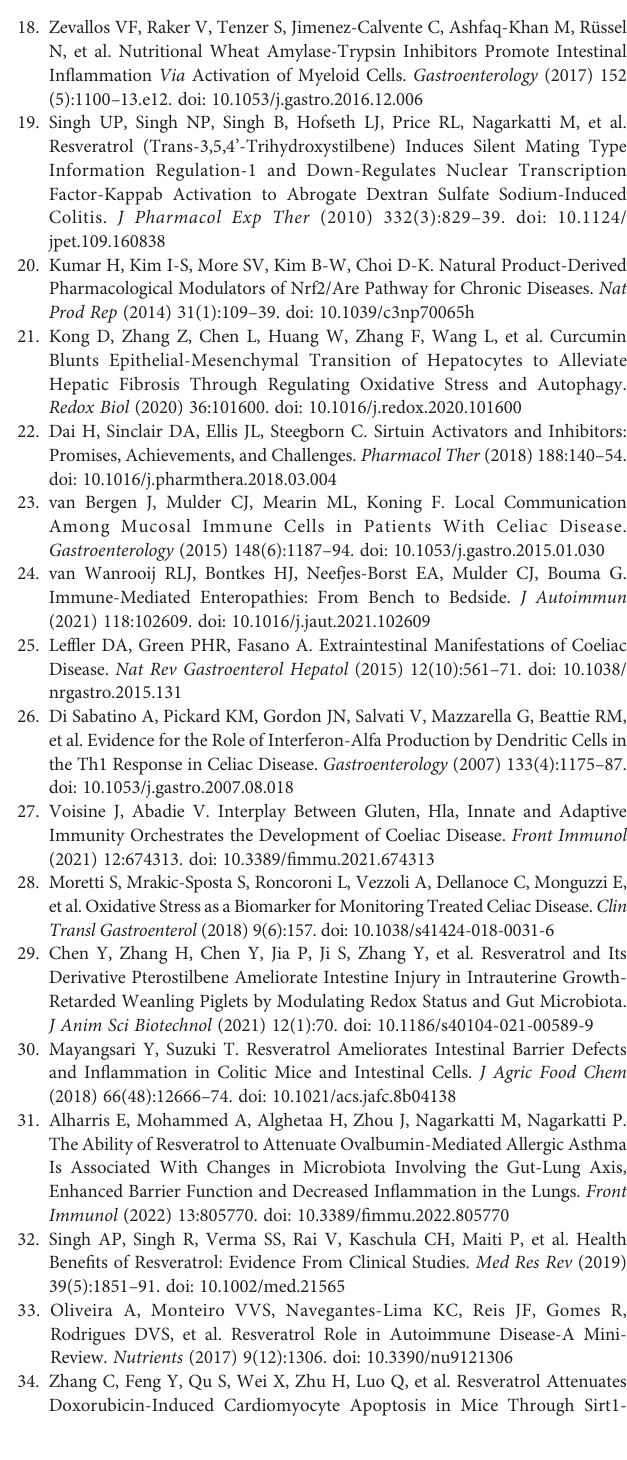
Supplementary Figure 5 | Average optical density analysis of tissue transglutaminase in jejunum tissue